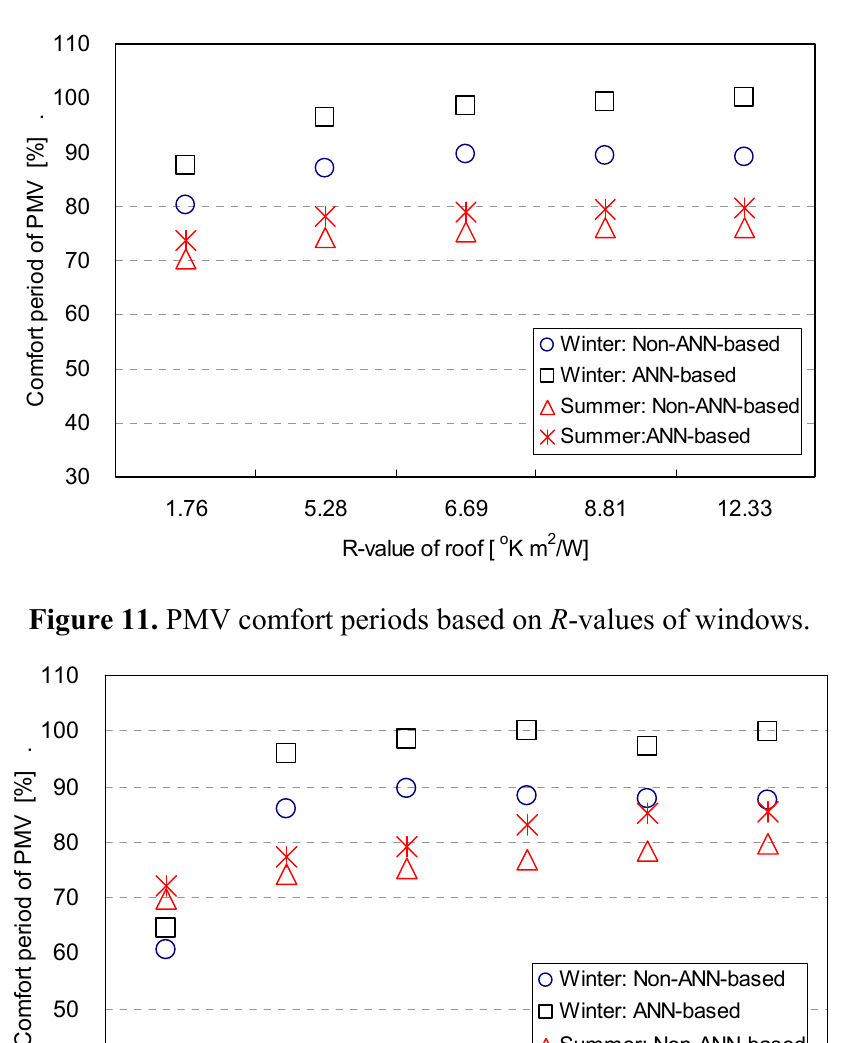
Figure 10. PMV comfort periods based on R -values of roof.